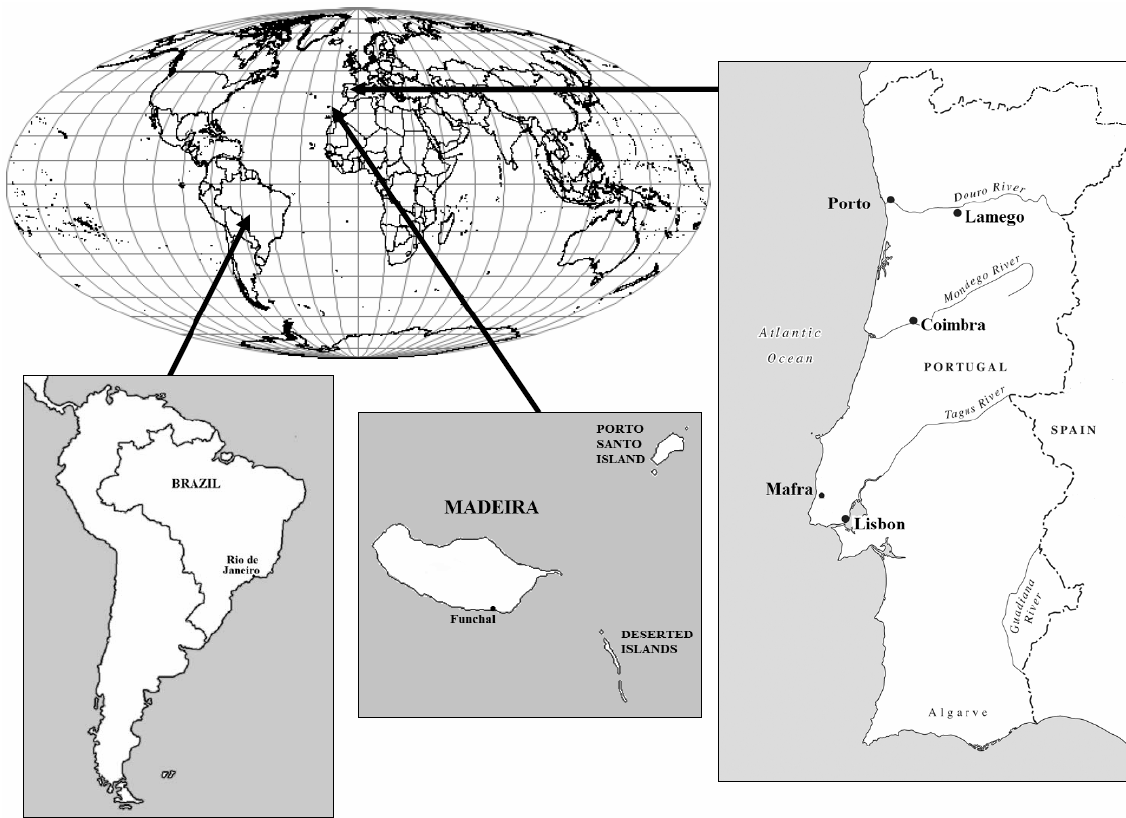
Fig. 1. Location Figure 1. Location maps